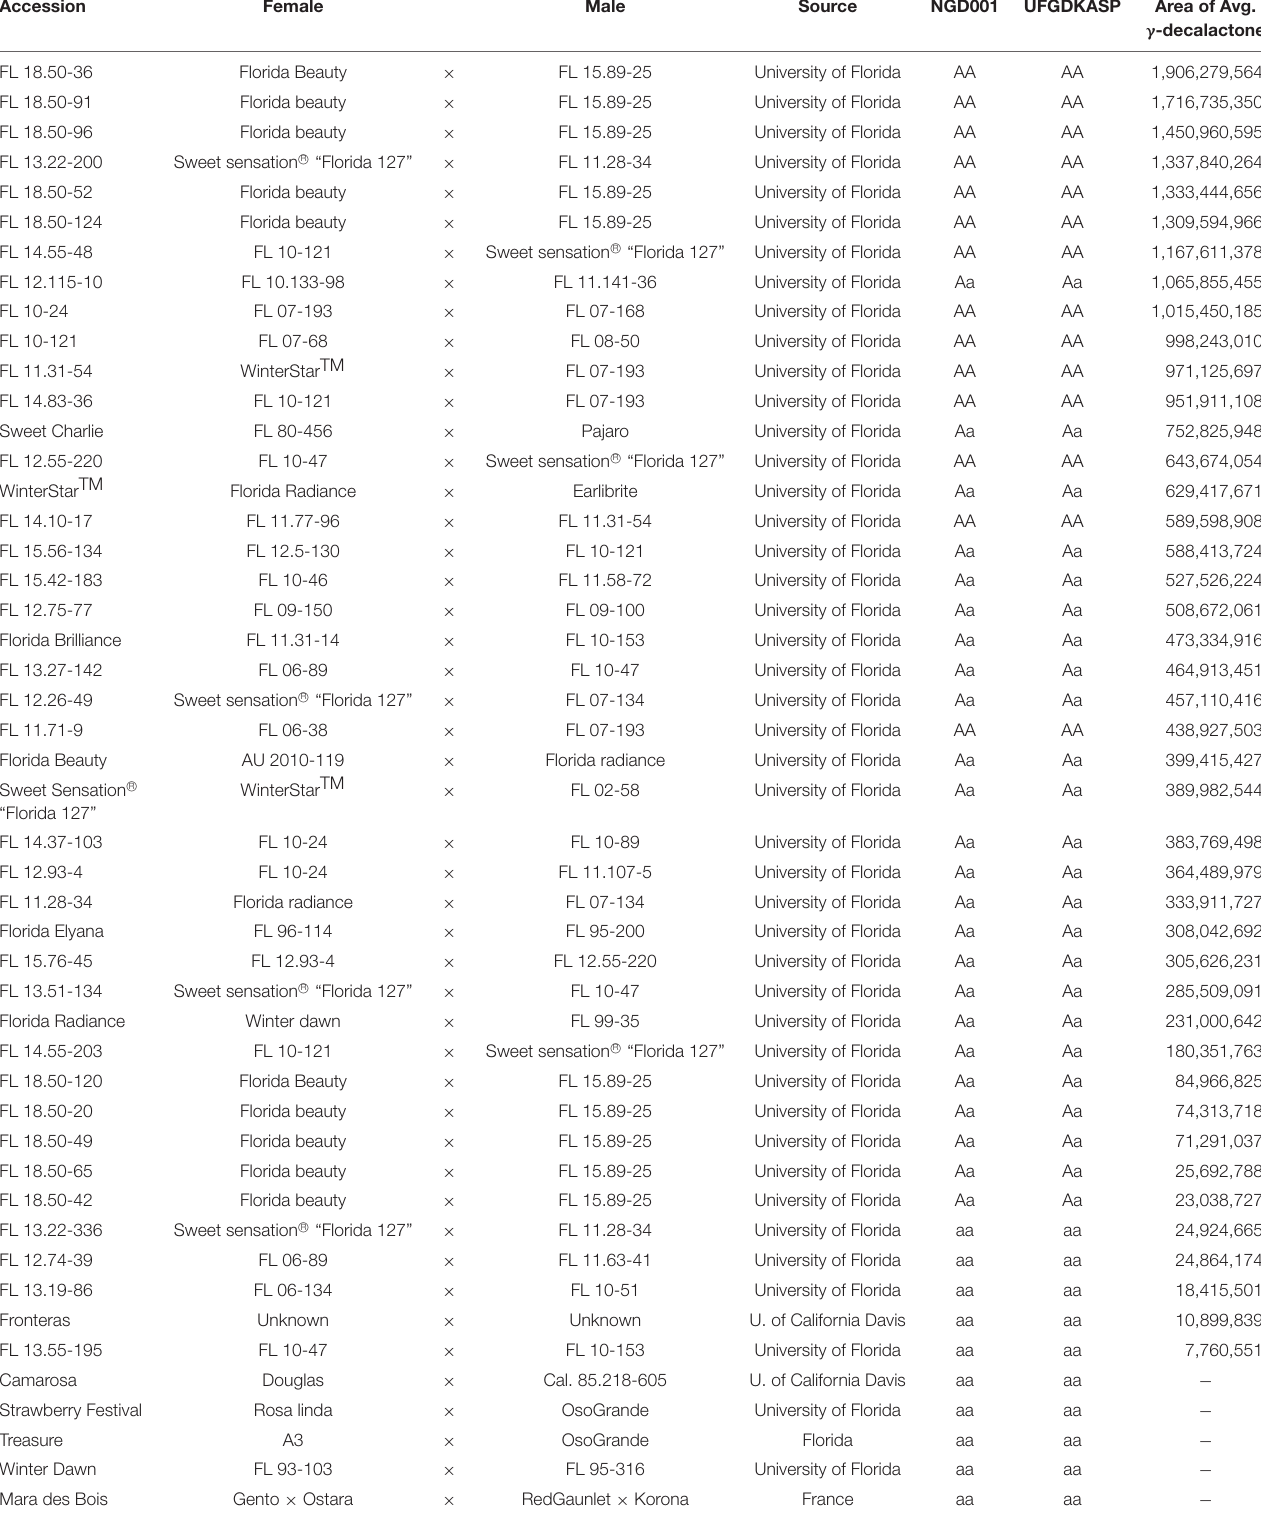
TABLE 2 | Markers genotype data and volatile content of γ -D in 48 accessions using HRM and KASP markers, and gas chromatography/mass spectrometry.